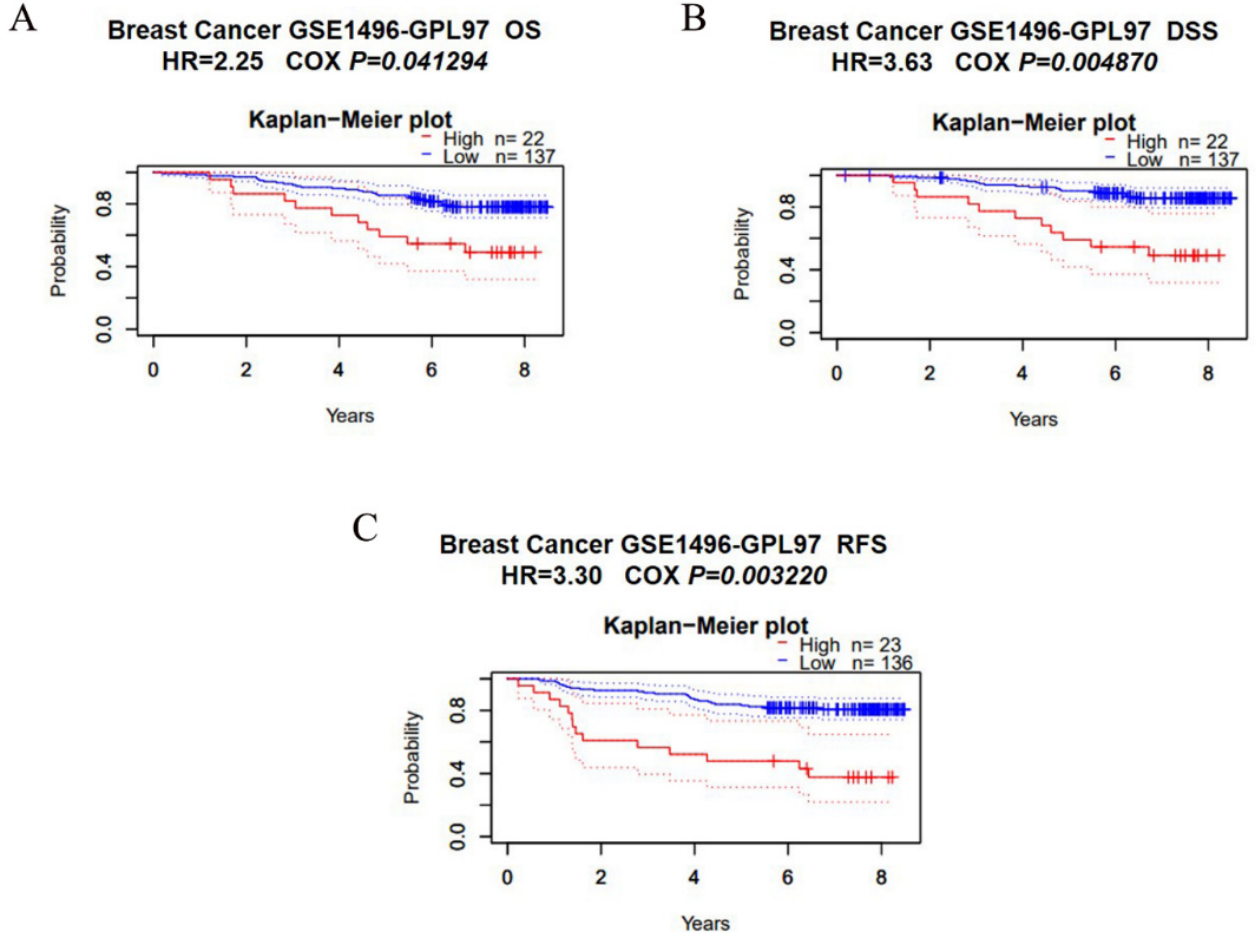
Figure 3. Expression of SCYL1 is associated with poor clinical prognosis. ( A – C ) the correlation between SCYL1 expression and prognostic value of BC was obtained through the PrognoScan. OS, overall survival; DSS, Disease special survival; RFS, Relapse free survival.